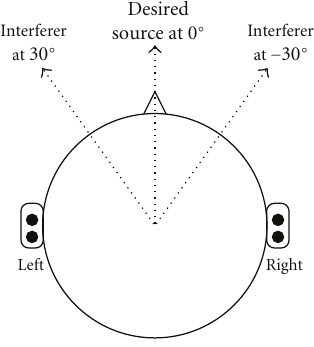
Figure 5: Location of desired and interfering sources. For an interferer located at 30 ◦ , the SIR at the left ear is lower than at the right ear due to head